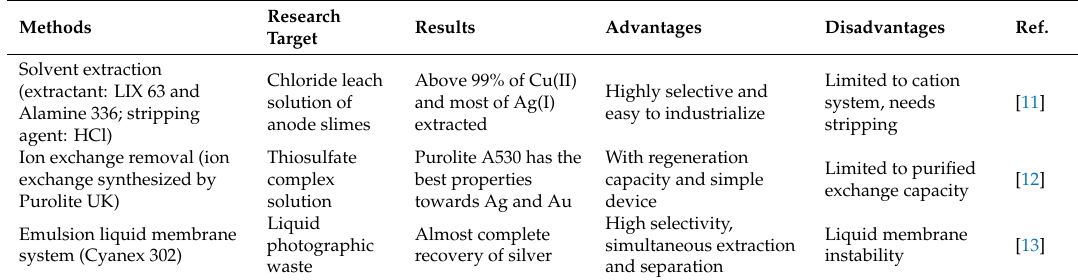
Table 1. The advantages and disadvantages of di ff erent traditional